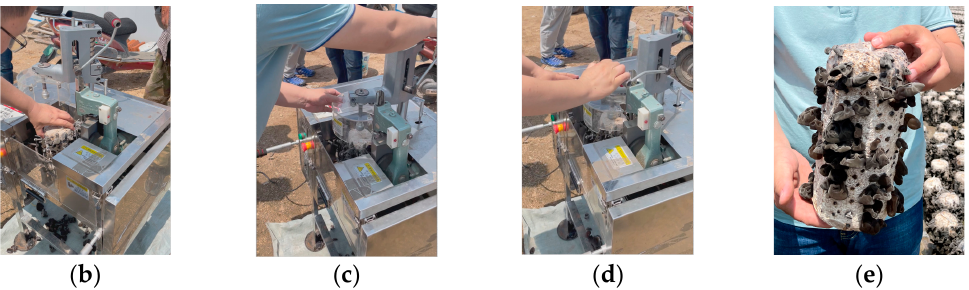
Figure 2. Operation process of Auricularia auricula harvester. ( a ) Bacteria sticks to be collected. ( b ) Put the bacteria stick into the equipment. ( c ) Fix the bacteria stick. ( d ) Press the switch to harvest. ( e ) Harvesting completed.